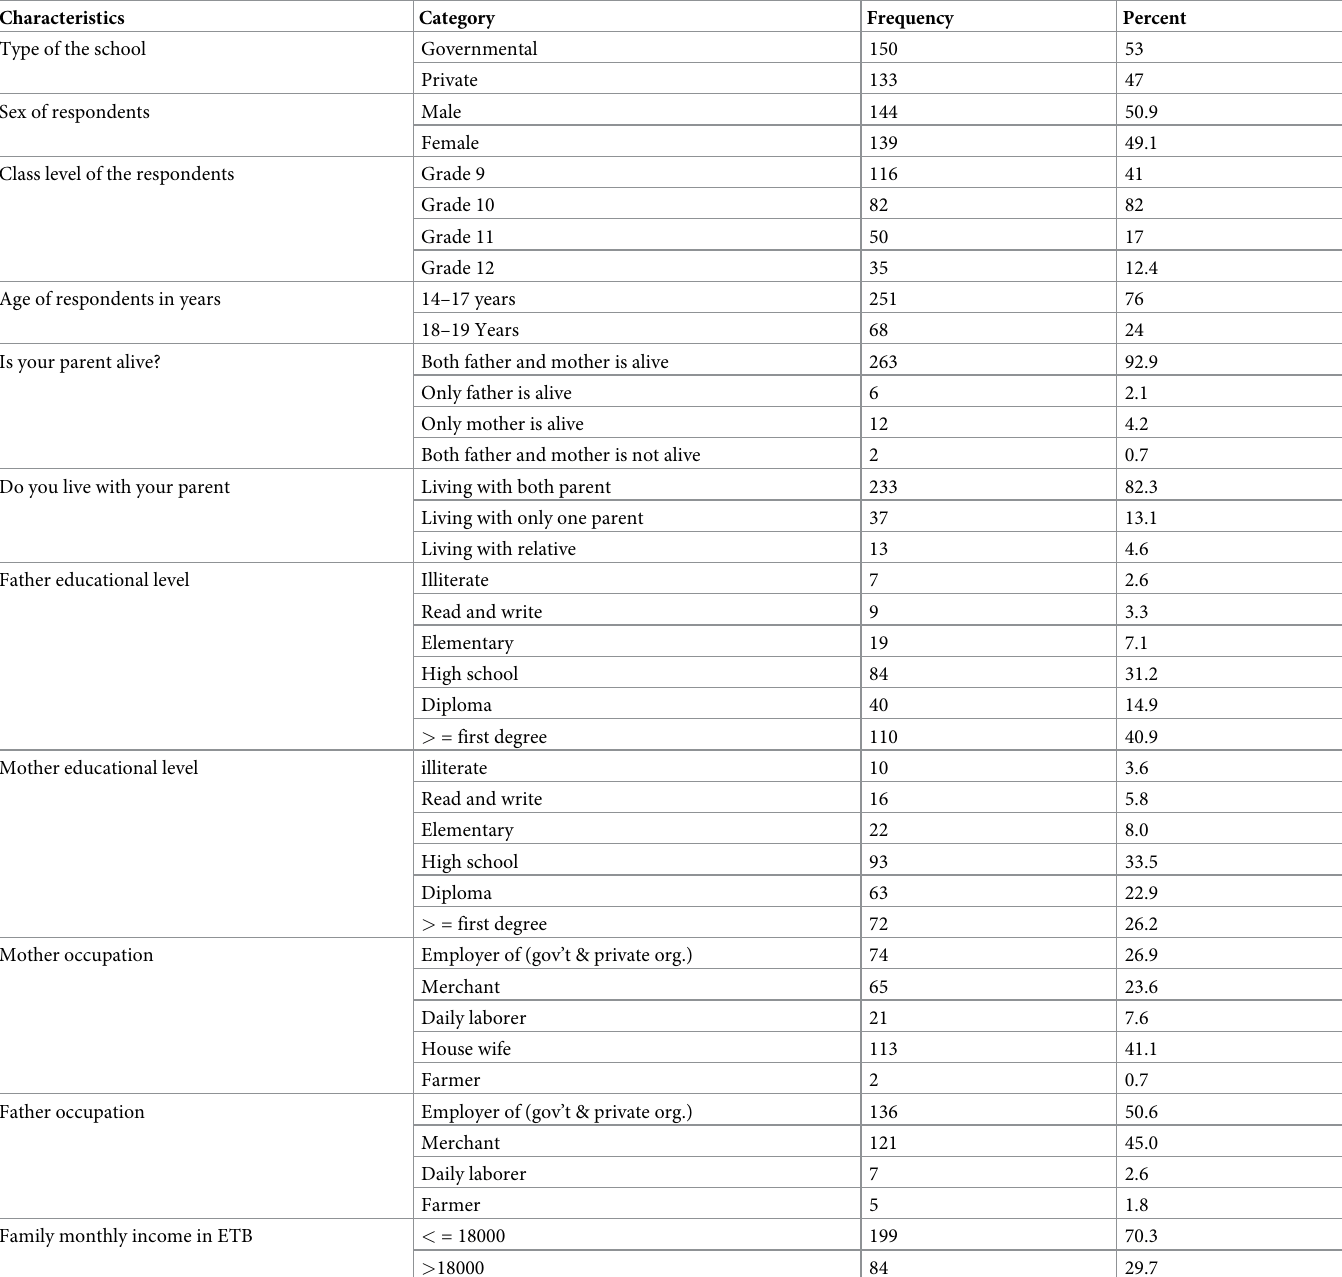
Table 1. Distribution of socio-demographic characteristics of adolescents in Addis Ababa city, Ethiopia.